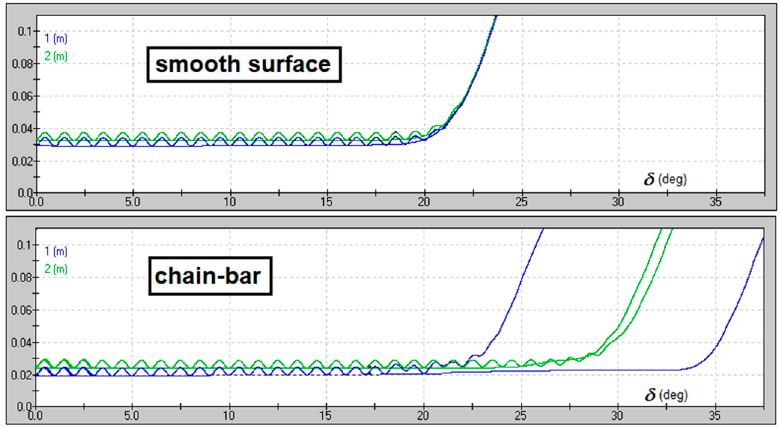
Figure 5. Working Model 2D simulation results for the smooth surface and chain bar transporter with and without vibration.